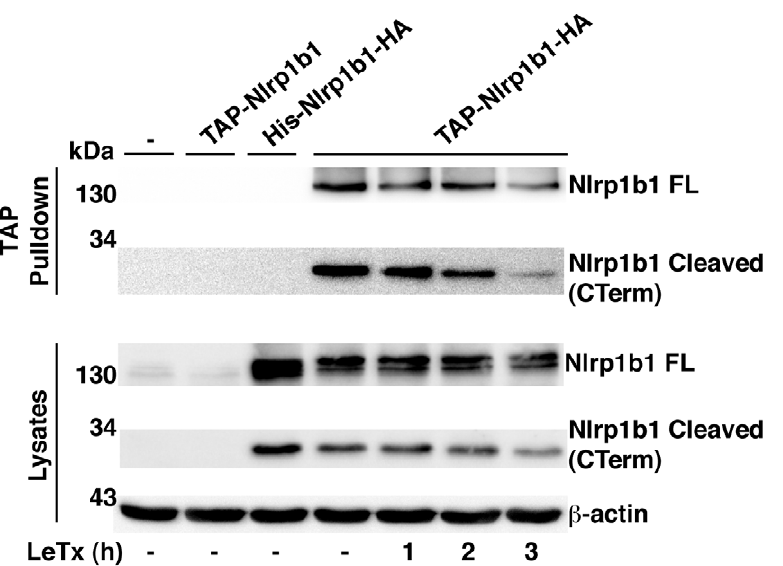
Figure 7. The cleaved products of Nlrp1b1 remain associated. (A) HT1080 cells were transfected with the indicated Nlrp1b1 plasmids. Approximately 24 h following transfection, cells were treated with LeTx (10 2 8 M LF and 10 2 8 M PA) for the indicated times. Cells were lysed and TAP- tagged proteins were precipitated with streptavidin resin. Proteins from the precipitates and the lysates were immunoblotted with antibodies against HA and b -actin. Blots represent three independent experiments. doi:10.1371/journal.ppat.1002659.g007 nearby V988D mutation in Nlrp1b1 abolished cleavage and the after a phenylalanine residue in a conserved SFS motif [23], which corresponding swap mutation in Nlrp1b3 caused this protein to be corresponds to 982 SFS 984 in Nlrp1b1. Notably, we found that the cleaved. Furthermore, the TEV site that allowed activation of